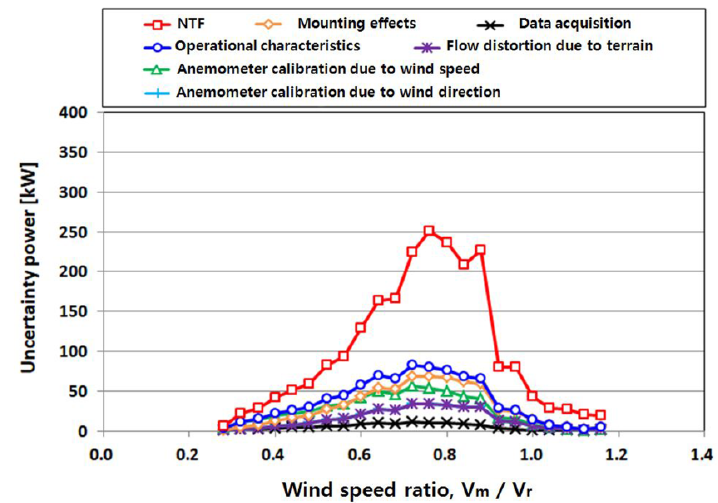
Figure 9. Uncertainties of each component comprising the uncertainty in wind speed of wind turbine no. 15.